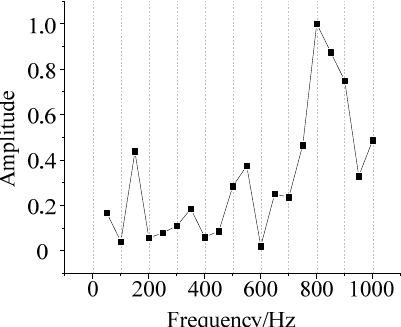
Figure 8. DC bias state frequency spectrum distortion function. The core model frequency spectrum E M ( f ) is shown in Figure 9a. A simulated real transformer frequency spectrum E R ( f ) can be calculated by H ( f ) given in Figure 6, D(f) given in Figure 7, and Formula (7).